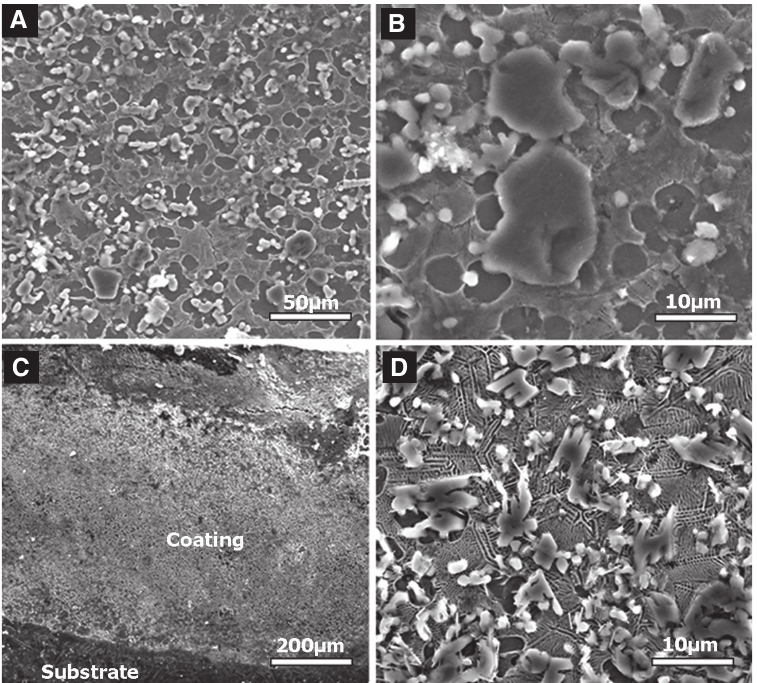
Figure 1 SEM micrographs of the composite coating in samples 1 (A, B) and 2 (C, D): (A) microstructure, (B) the TiC morphology, (C) overview cross-section, and (D)